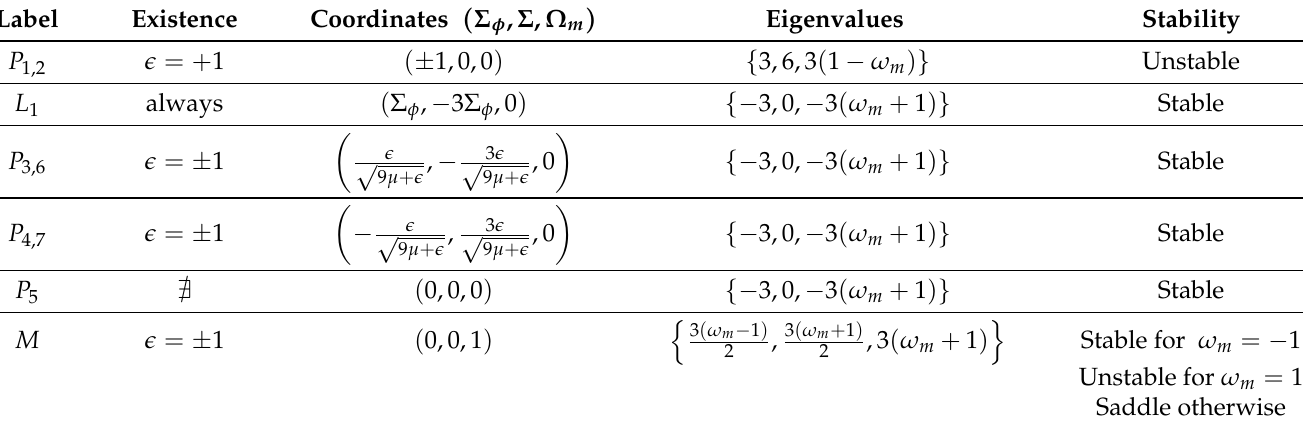
Table 4. Equilibrium points of System (82), (83), and (84) for (cid:101) = ± 1 with their eigenvalues and stability.